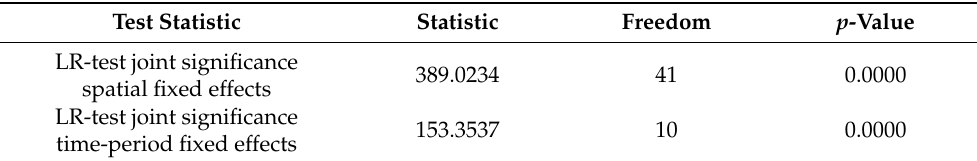
Table 4. Likelihood ratio test